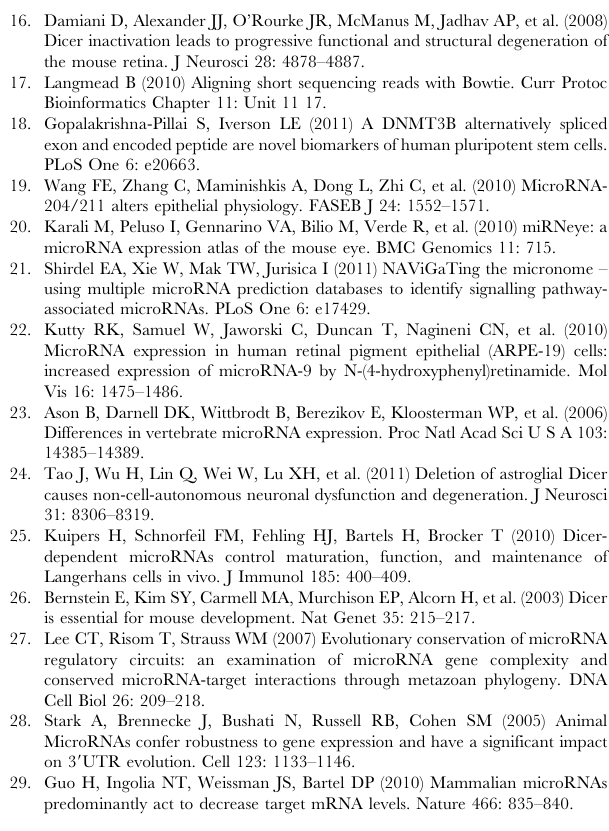
Figure S1 Functional annotation from Gene Ontology analysis of miRNAs specifically expressed in human RPE cells. Table S1 Gene expression data sets of various somatic tissues from